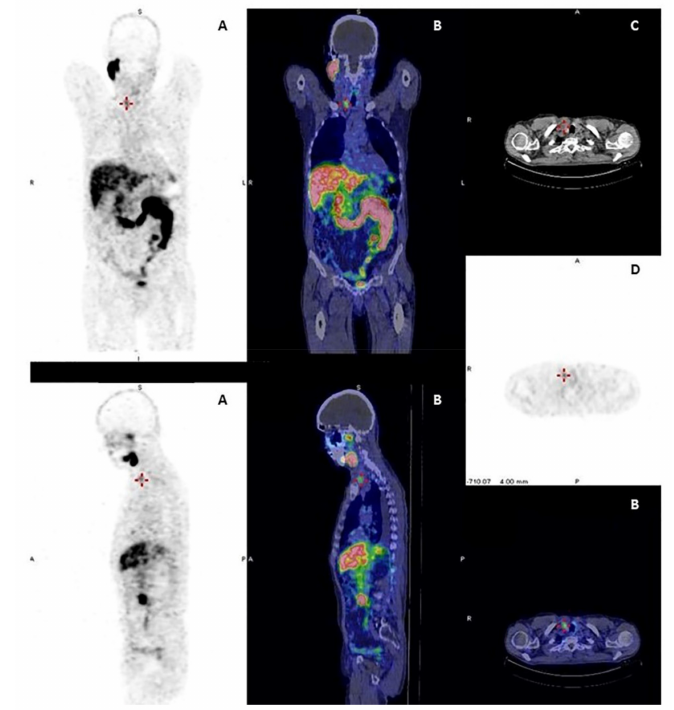
Figure 3. A 76-year-old patient with prostate cancer and a right thyroid nodule of 15 mm in diameter. Multiple image projections ( A ), fusion PET-CT images ( B ), CT images ( C ) and PET images ( D ), respectively, of 68 Ga-PSMA imaging with high-intensity PSMA accumulation. Fine needle aspiration biopsy of PSMA-avid thyroid lesion was performed revealing an indeterminate cytology. Final histology revealed papillary thyroid